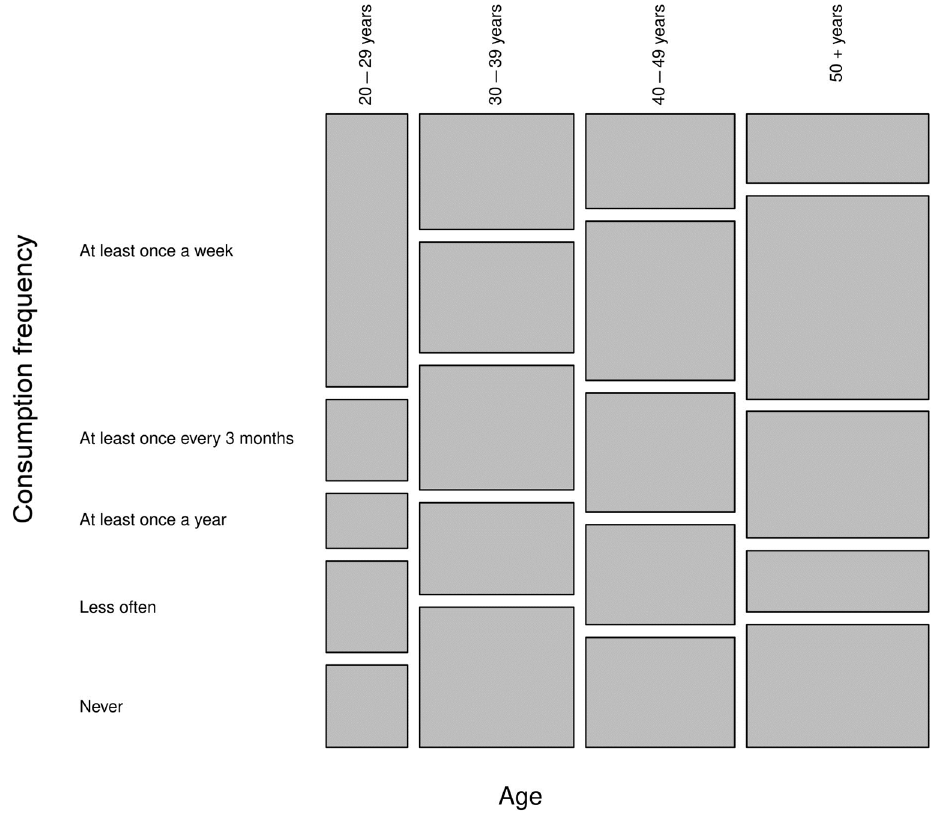
Figure 2. The mosaic display of the relationship between the respondent’s age and consumption frequency ( n = 445).